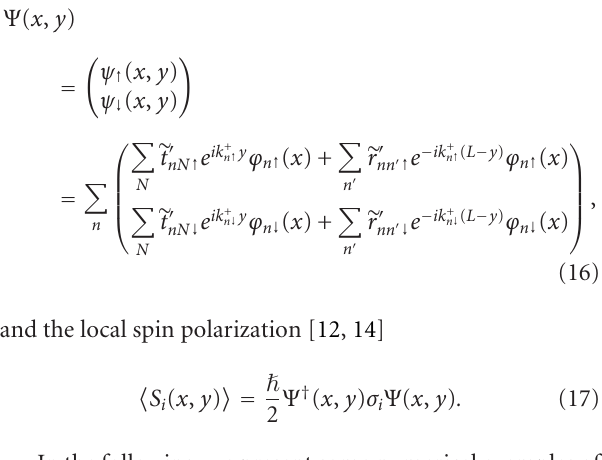
where the corresponding matrices elements are as follows (cid:25) W/ 2 p nn (cid:8) ↑ ( ↓ ) = − W/ 2 ϕ n ↑ ( ↓ ) ( αx ) ϕ n (cid:8) ↑ ( ↓ ) ( αx ) dx , χ nn (cid:8) ↑ ( ↓ ) (cid:25) W/ 2 × − W/ 2 ϕ n ↑ ( ↓ ) ( αx ) ϕ n (cid:8) ↓ ( ↑ ) ( αx ) dx , λ Nn ↑ ( ↓ )